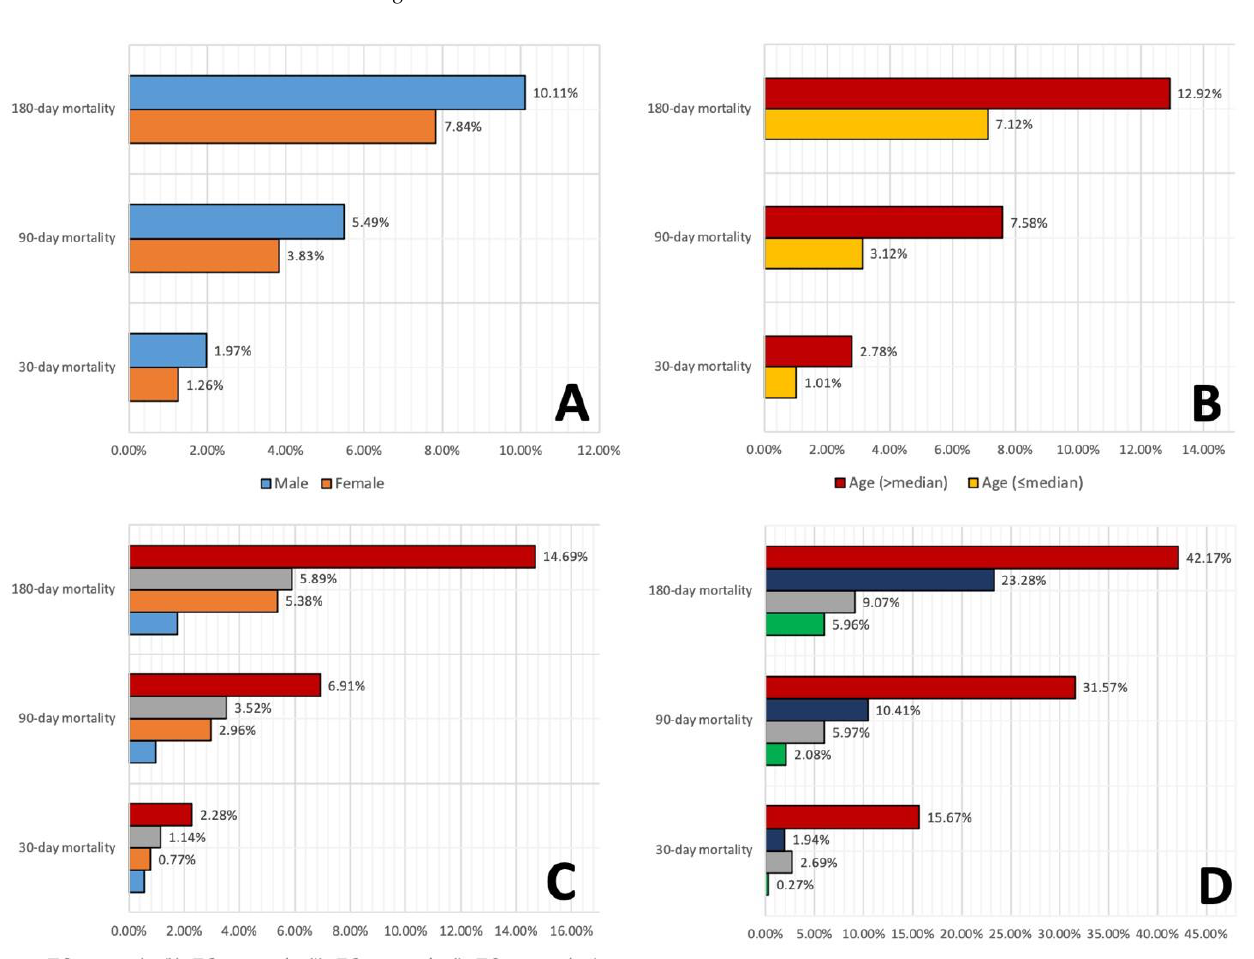
associated with higher early mortality probability. Higher T-, N-, and M-classification and advanced cancer stage showed significant influence for all inclusion periods of 30-day, 90- day, and 180-day mortality (all p < 0.001). Tumor localization showed no significant im- pact on the 30-day mortality ( p = 0.084). The probability of 90-day and 180-day mortality varied depending on the primary tumor localization ( p < 0.001). The worst prognosis was found for tumors located in the cavity of the mouth (25.9%), oropharyngeal (32.6%), and hypopharyngeal carcinoma (17.5%) with death occurring within 180 days ( p < 0.001). Any treatment type also showed a significant influence on early mortality for all in- clusion periods (all p < 0.001). Patients who underwent radiotherapy (death within 30 days: 7.3%; death within 90 days 13.8%; death within 180 days: 16.5%), surgery (death within 30 days: 39.1%; death within 90 days: 30.8%; death within 180 days: 24.9%) or mul- timodal therapy (death within 30 days: 8.6%; death within 90 days: 23.2%; death within 180 days: 35.6%) had lower risk for early mortality (all p < 0.001). In summary, patients’